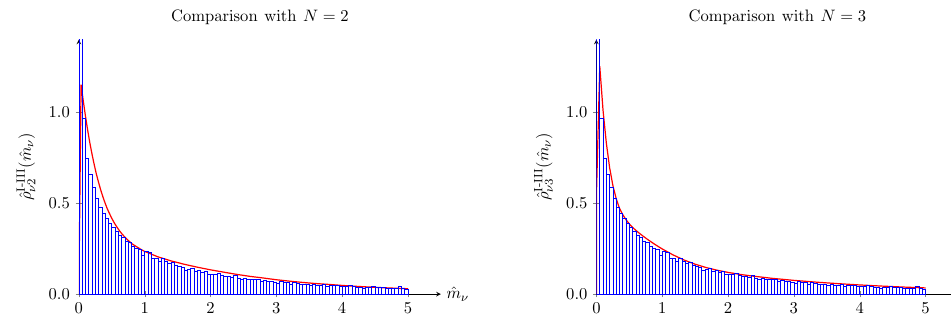
Figure 8 . Comparison between the correlation function at N = 2 and N = 3 (red curves) and the level density at large N (histogram with N = 60) for the type I-III complex seesaw ensemble. The red curves correspond to the analytic result for these speci(cid:12)c values of N while the histograms correspond to numerical results (with 10 3 dimensionless light neutrino mass matrices generated). The left and right panel show the comparison with N = 2 and N = 3 respectively. There is no ordering of the singular